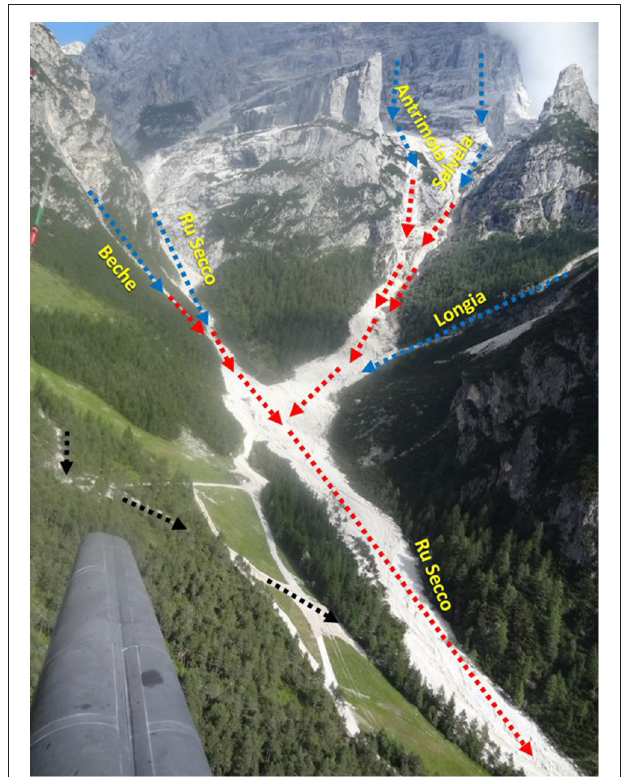
FIGURE 2 | Frontal view of the upper basins that contributed to the phenomenon. The blue arrows show the runoff routing, the red arrows the debris flow starting locations and its routing, and the black arrows the path of the debris flow on the right slope, that did not contribute significatively to solid-liquid wave routing along Ru Secco (flight of 5 August